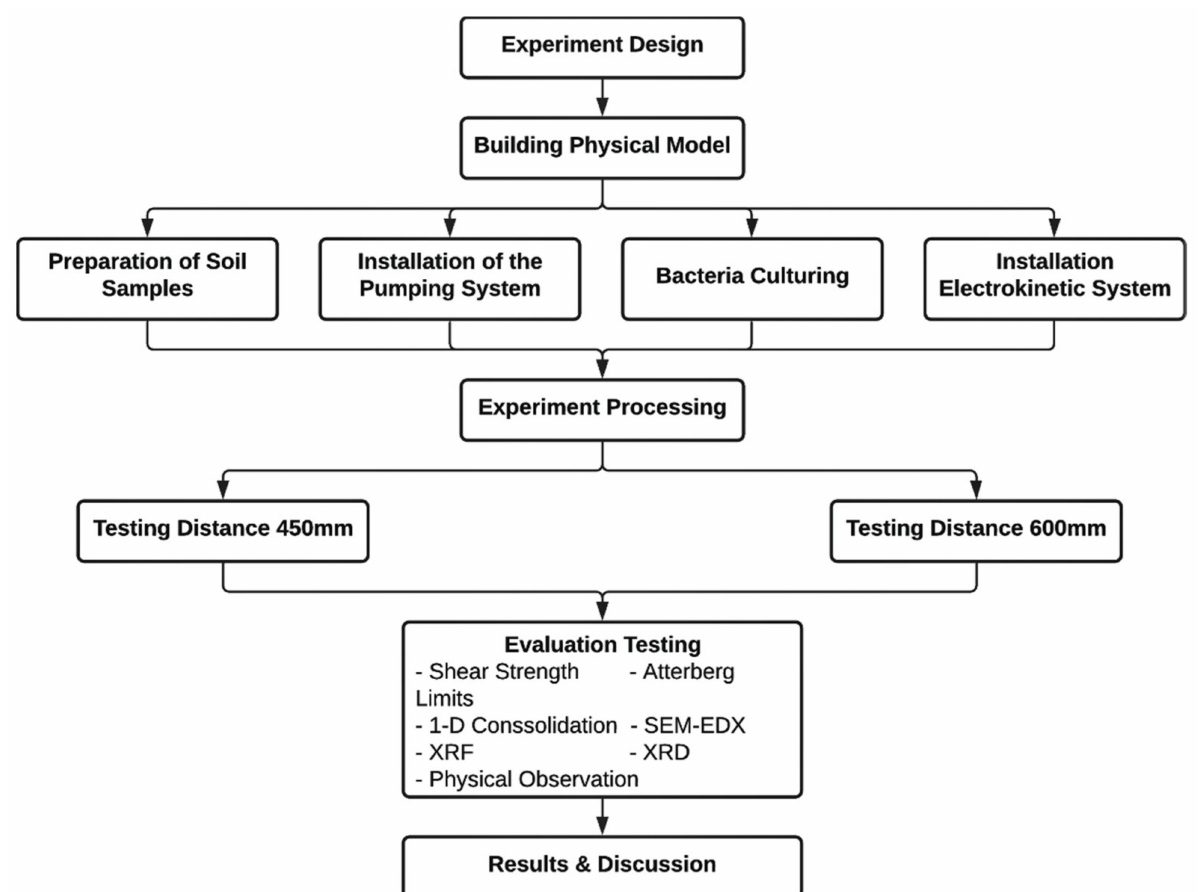
Figure 5. The experimental work’s